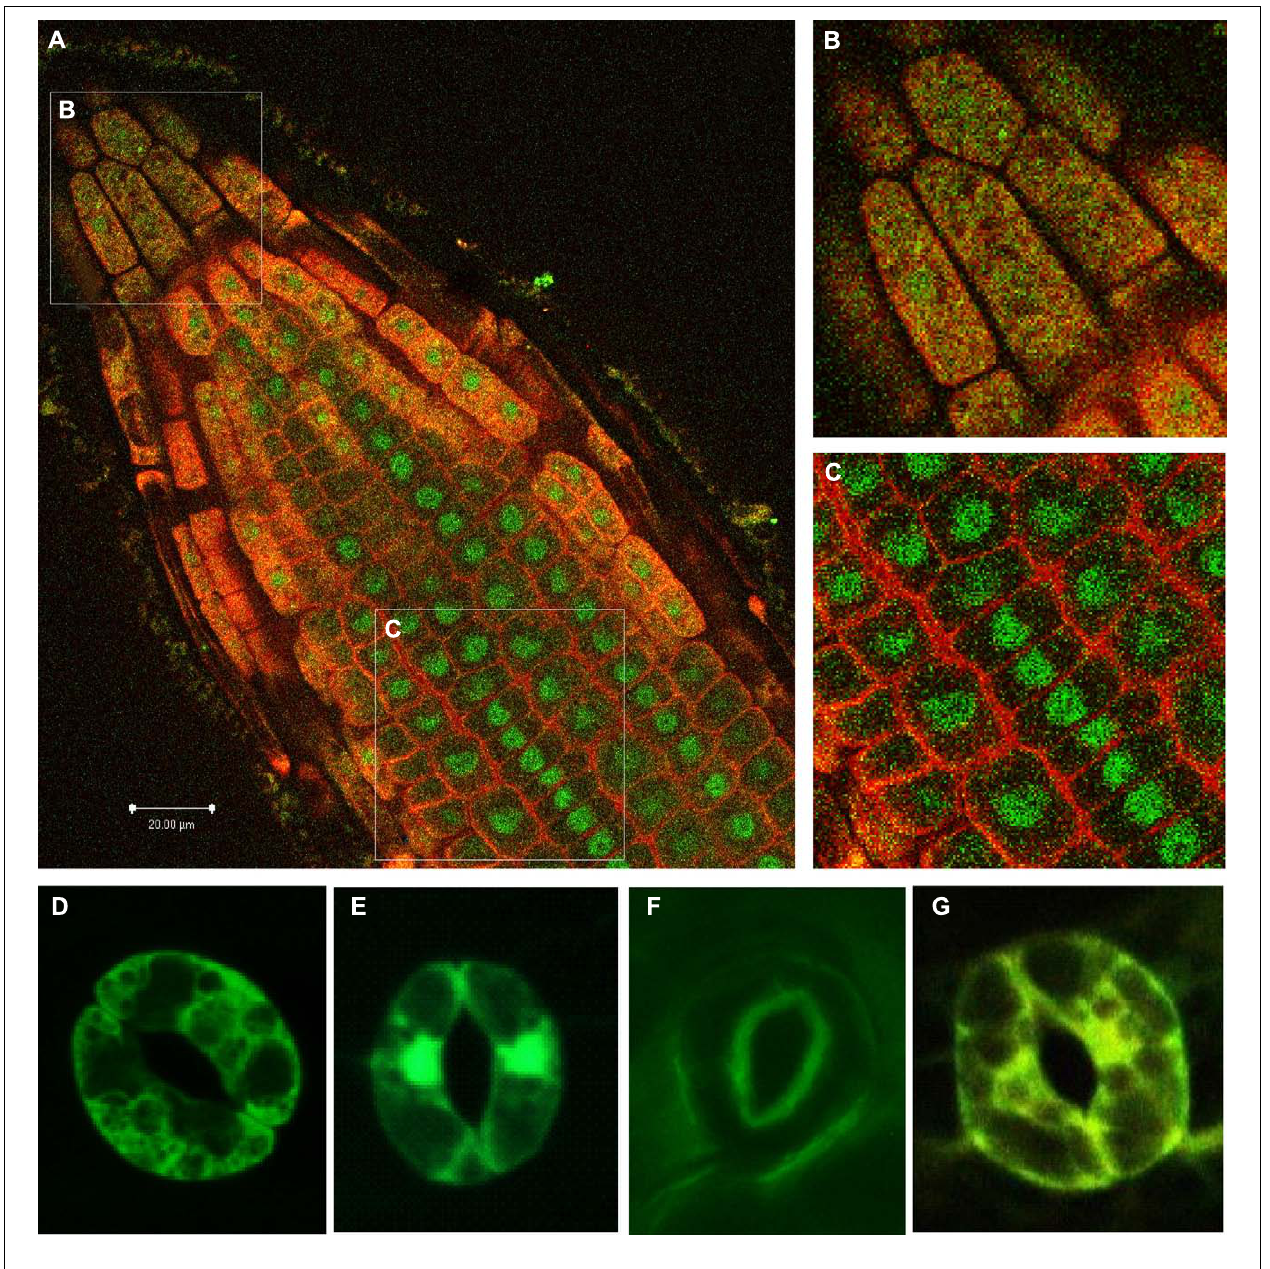
FIGURE 6 | Distinctly different 14-3-3 localizations determined by confocal microscopy ofArabidopsis. Isoform-specific antibodies that have been directly labeled with either Alexa-488 or Alexa-568 and used for in situ labeling. 14-3-3 λ (green) predominates in the nucleus while 14-3-3 ε (red) predominates in the cytoplasm and plasma membrane. A single longitudinal optical slice of a root tip is shown in (A) . (B,C) Provide closer views of the